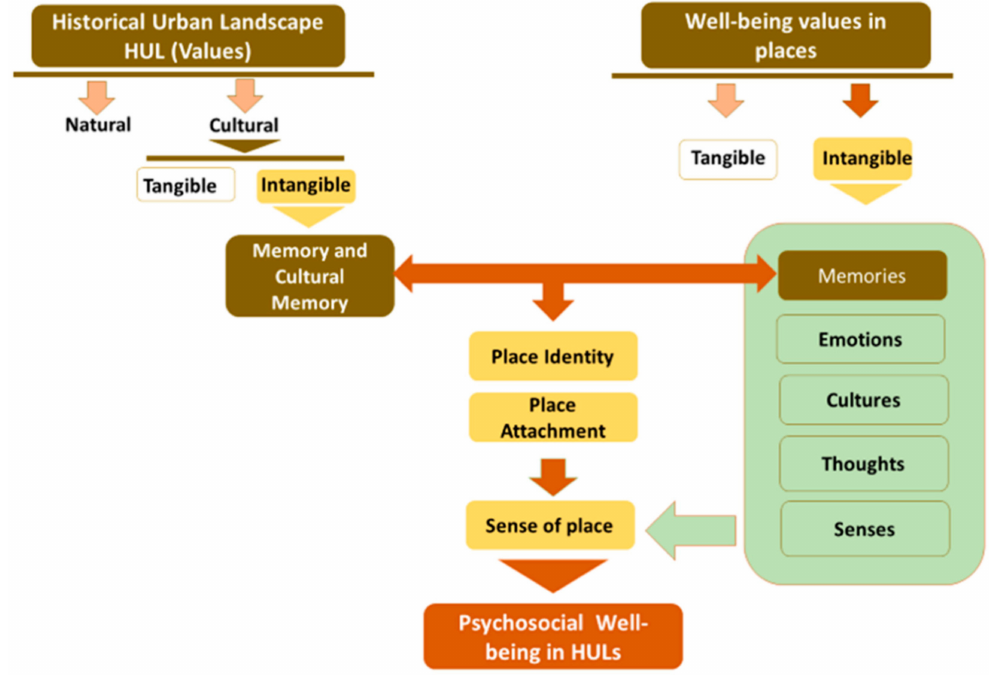
Figure 2. Diagram showing the existing relationships between the concepts of HUL, cultural memory and psychosocial well-being. Source: